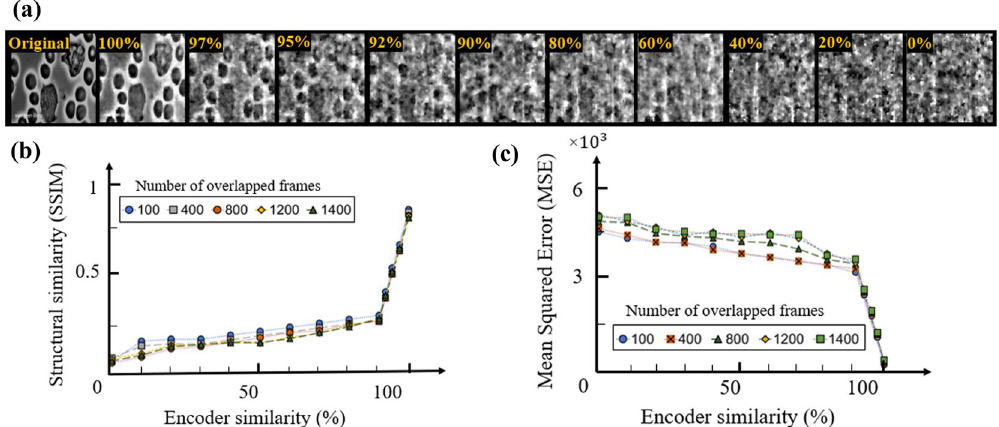
Figure 4. ( a ) Reconstructed frames, ( b ) SSIM and ( c ) MSE measurements of the immune cell dataset for the partially known encoder data at various known percentages of the true values located at random pixel positions.